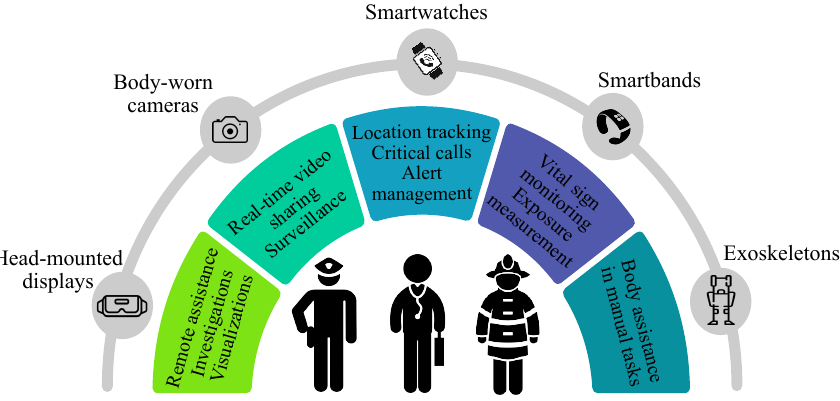
Figure 3. Examples of wearable-based public safety